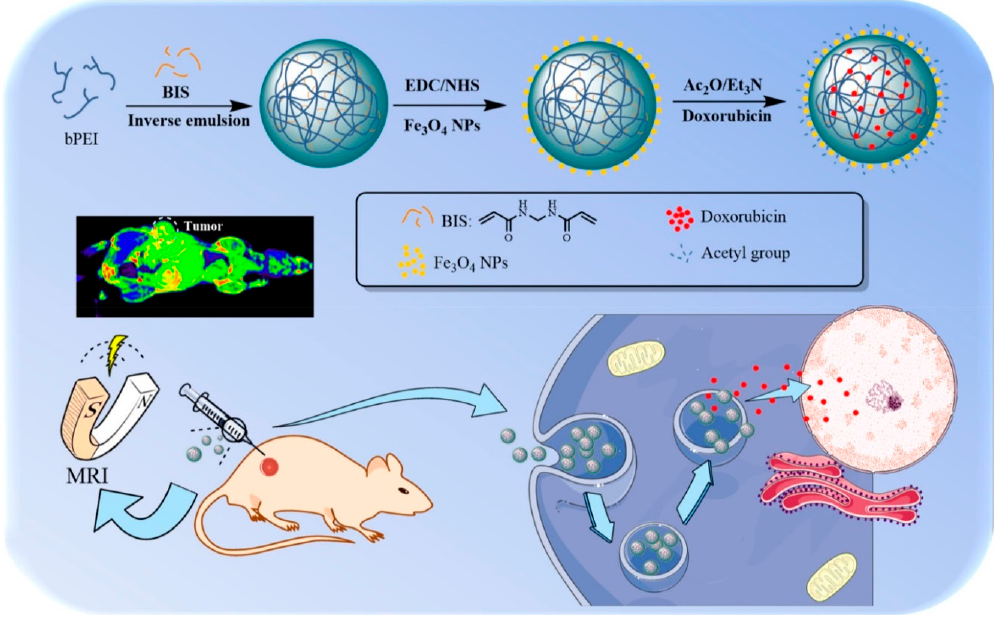
Figure 7. Schematic representation of the synthesis of Fe 3 O 4 /PEI-Ac NGs/DOX complexes for MR imaging-guided chemotherapy of tumors. Reproduced from [306] with permission from American Chemical Society, 2020.